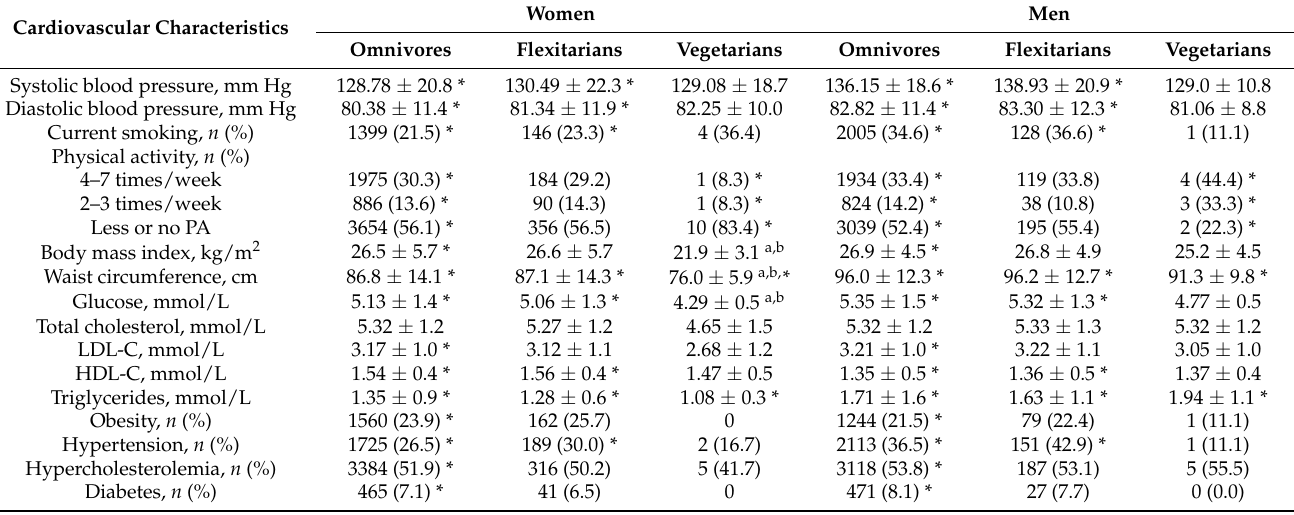
Table 6. Association between dietary pattern and cardiovascular characteristics in the studied groups. Cardiovascular